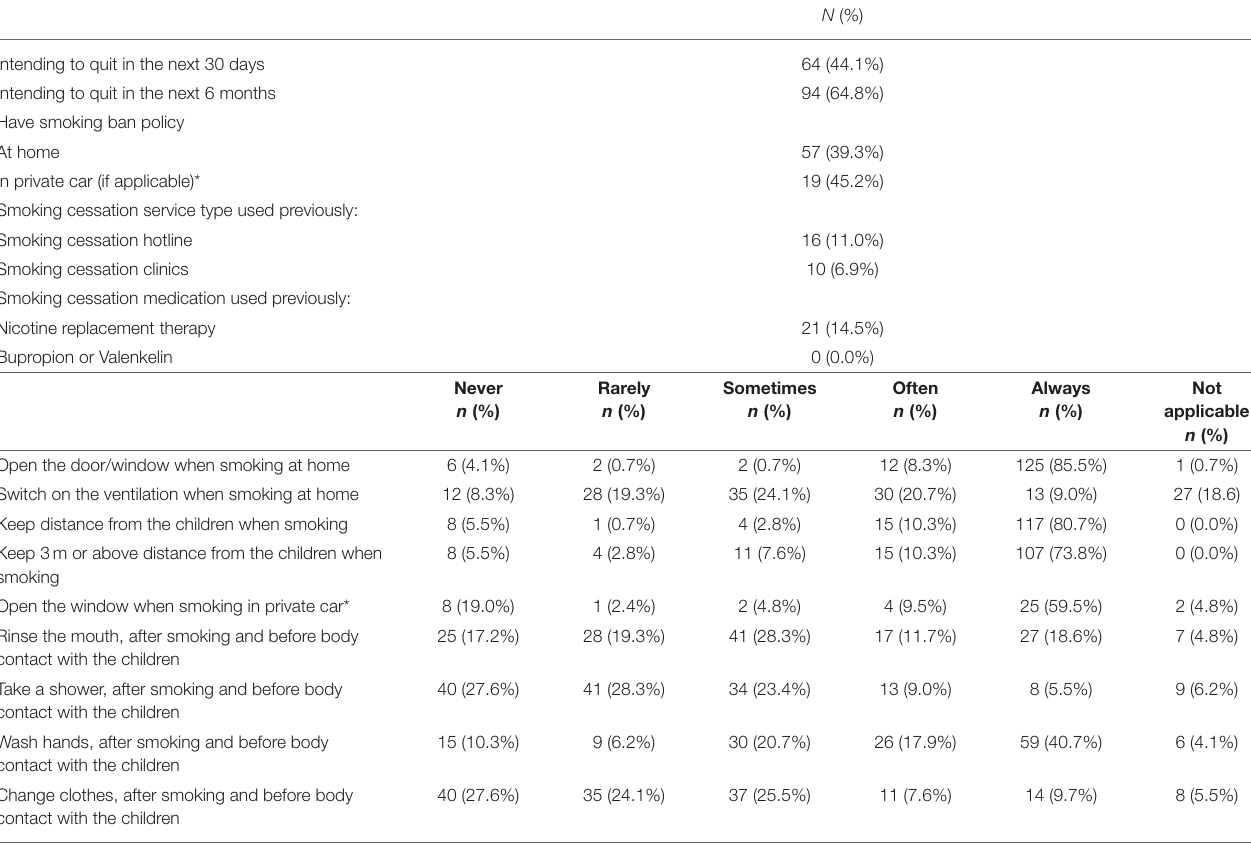
TABLE 3 | Parental practice on tobacco use and smoking cessation ( N =